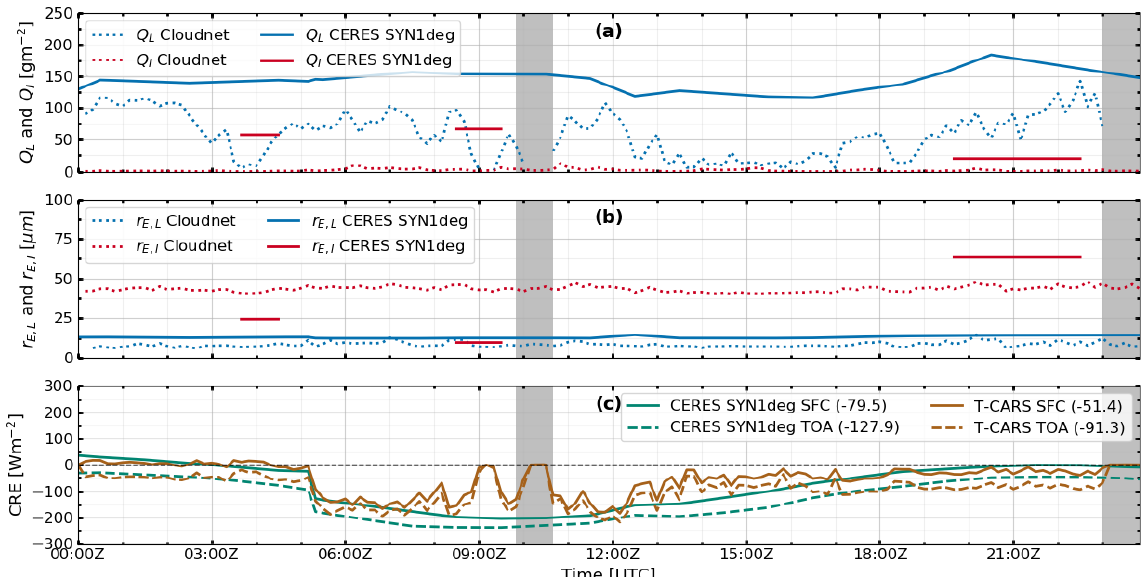
Figure 11. Same as Fig. 9, but for the 26 June 2017 case. The grey shading indicates periods with uncorrected attenuation by the Cloudnet